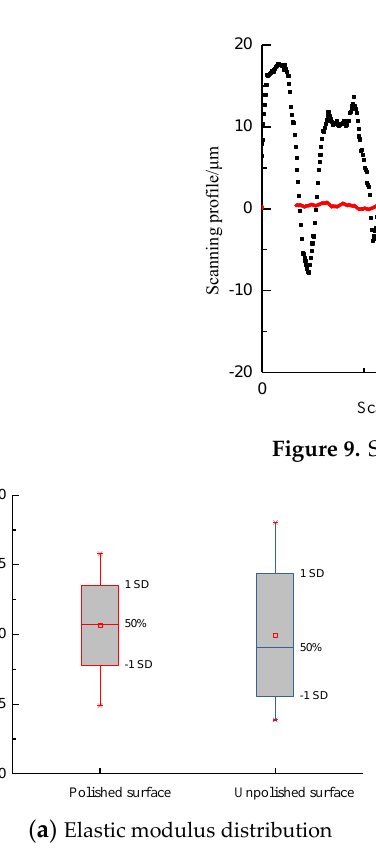
Figure 10. The relationship between surface properties and mechanical parameters.